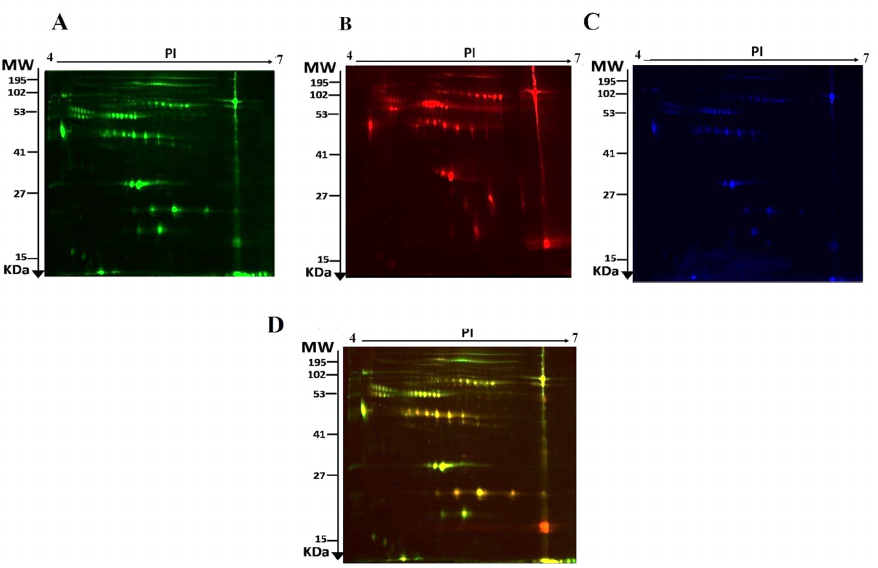
Figure 1 . Representative fluorescent proteins of a two-dimensional difference in gel electrophoresis (2D-DIGE) containing serum sample from Control labeled with Cy3 ( A ), Cannabis labeled with Cy5 ( B ), Pooled internal control labeled with Cy2 ( C ), and merged image ( D ).